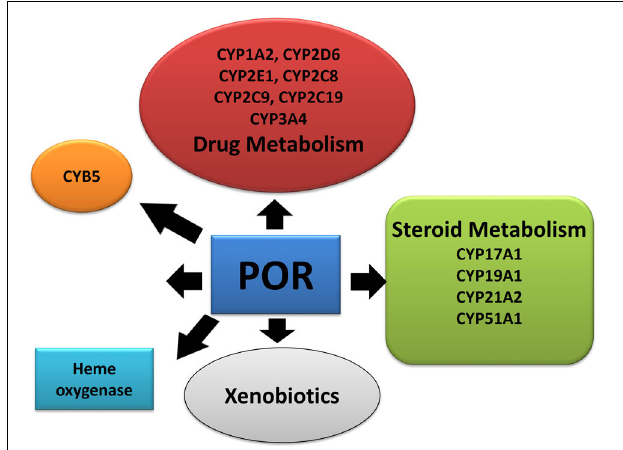
FIGURE 1 | Role of P450 oxidoreductase in biochemical pathways. POR is required for multiple metabolic processes especially the microsomal P450 enzymes involved in metabolism of xenobiotics.